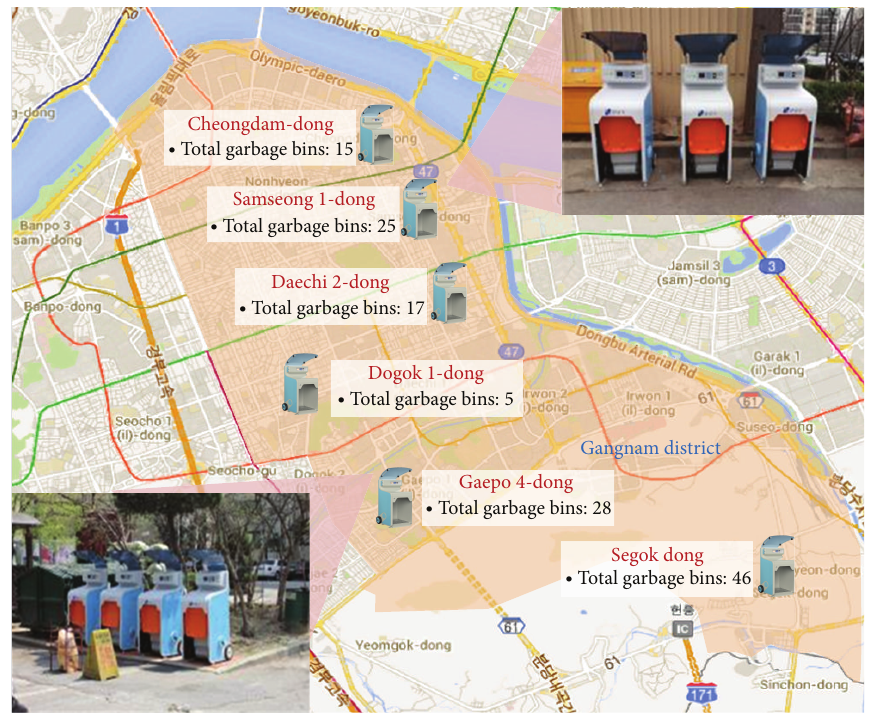
Figure 10: Implementation of a smart garbage